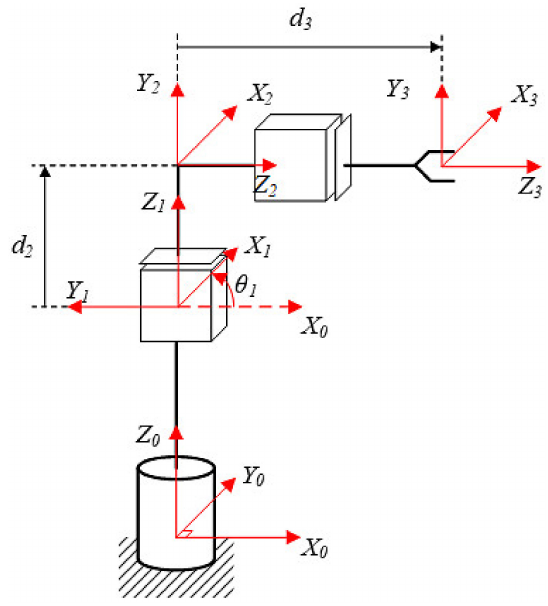
Figure 16. Attachment of local coordinates for each